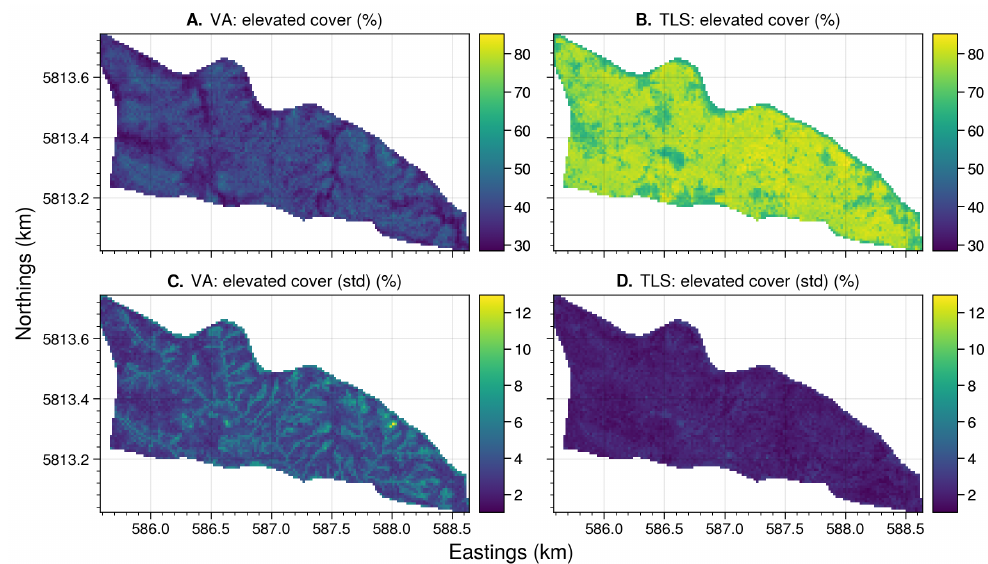
Figure A2. The mean and standard deviation of landscape level predictions for elevated fuel cover using visual assessments ( A , C ) and TLS ( B , D ) at Lakes Entrance.